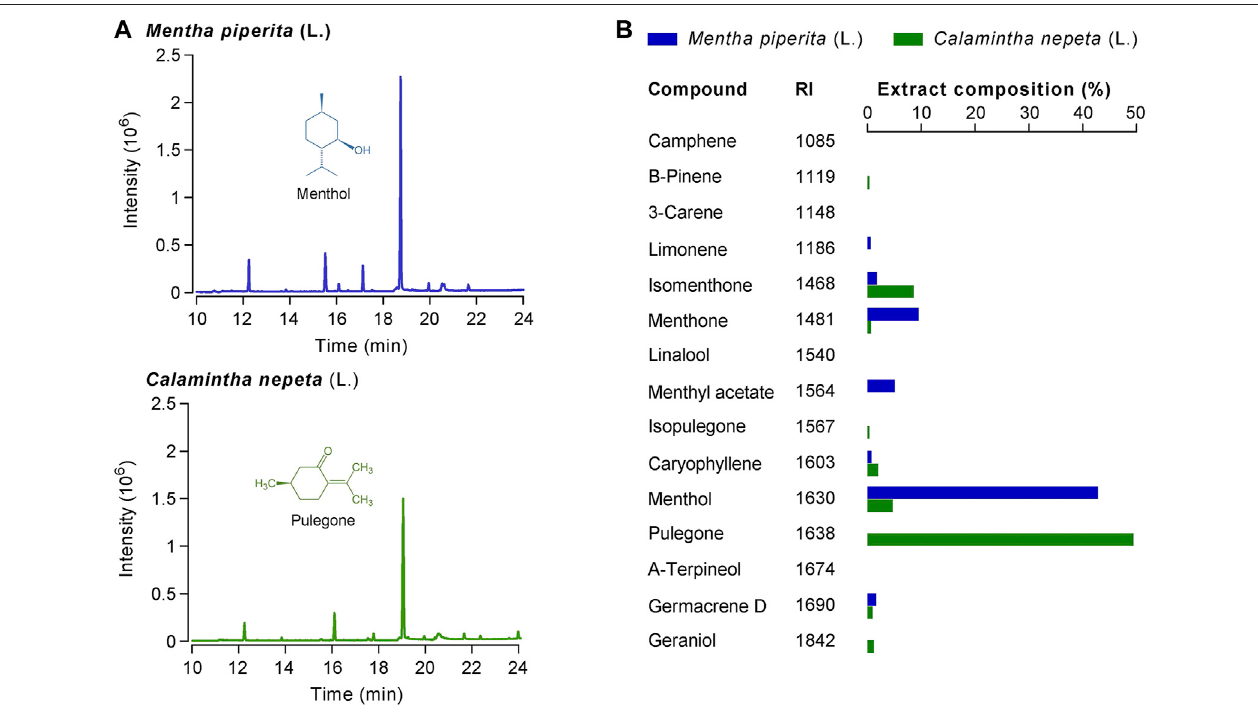
FIGURE 1 | (A) Chromatograms of Calamintha nepeta (L.) Savi and Mentha piperita L. PLE extracts 10-fold diluted were analyzed by GC-MS. On both chromatograms, the main components of each extract are identi fi ed: pulegone (T R (cid:1) 19.04 min) for C. nepeta and menthol (T R (cid:1) 18.75 min) for M. piperita . (B) Extract composition (in %) together with retention index (RI) of each found